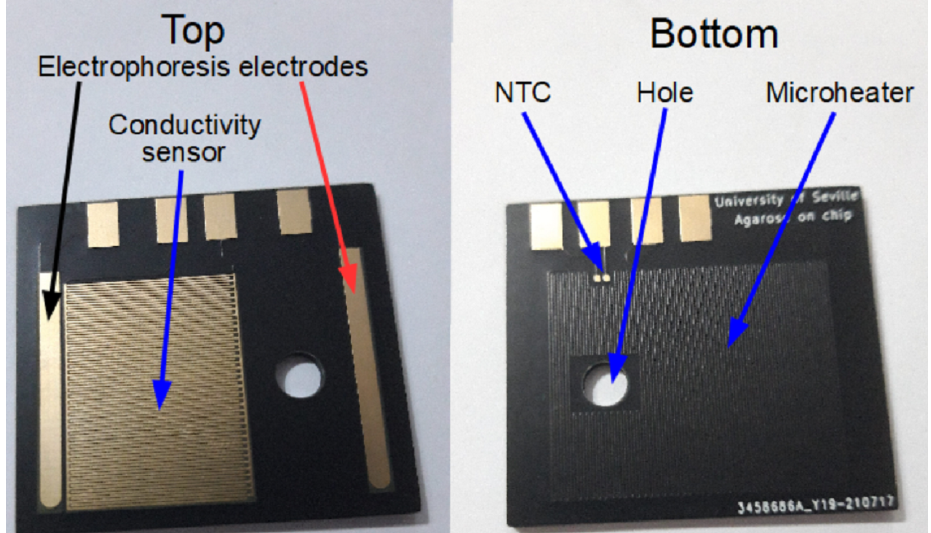
Figure 1. Printed circuit board substrate for agarose mixing and curing, and electrophoresis. ( Left ) Conductivity sensor and electrophoresis electrodes are shown. ( Right ) The microheater and the thermistor can be seen. The dimensions of the device are 38 × 34 mm 2